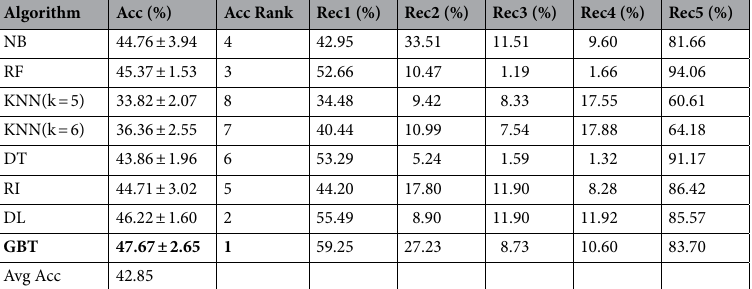
Table 2. The performance of different classification algorithms on 5-class-dataset according to GOS0: Acc, Rec, and Avg stand for accuracy, recall, and average, respectively.